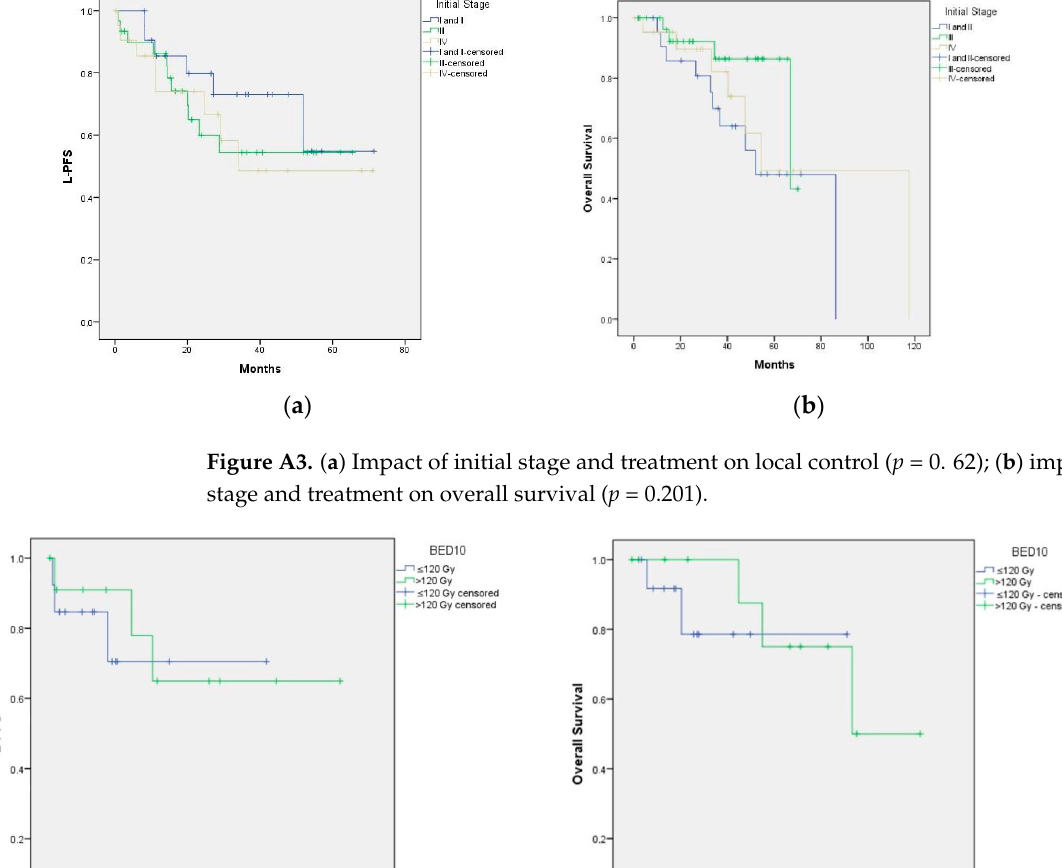
Figure A2. ( a ) L-PFS curves according to age at diagnosis of M1 (>70 or ≤ 70 years); ( b ) L-PFS curves according to treatment received. p = 0.860.